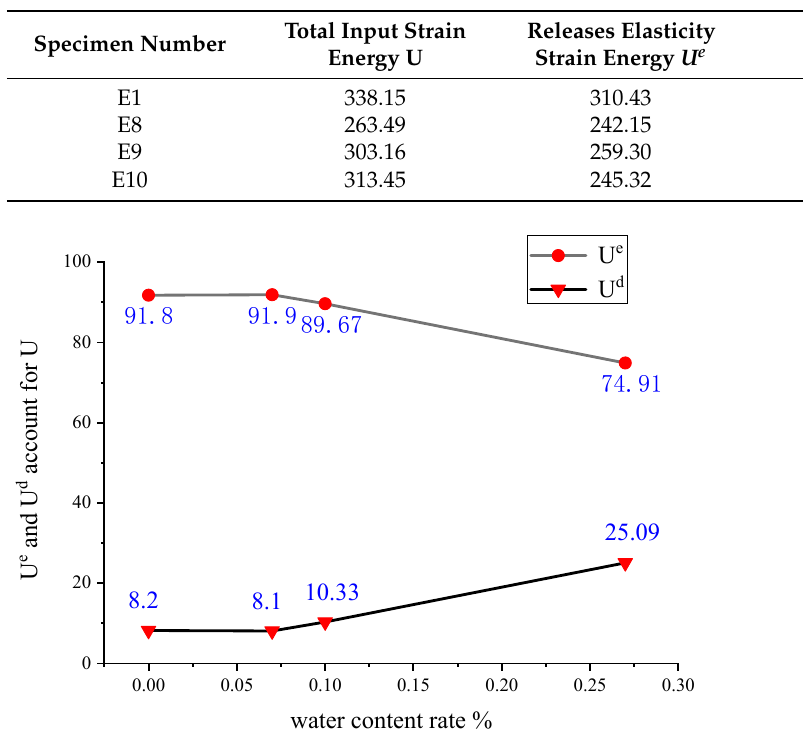
Figure 9. U e and U d account for U. Figure 9. 𝑈 (cid:3032) and 𝑈 (cid:3031) account for U.